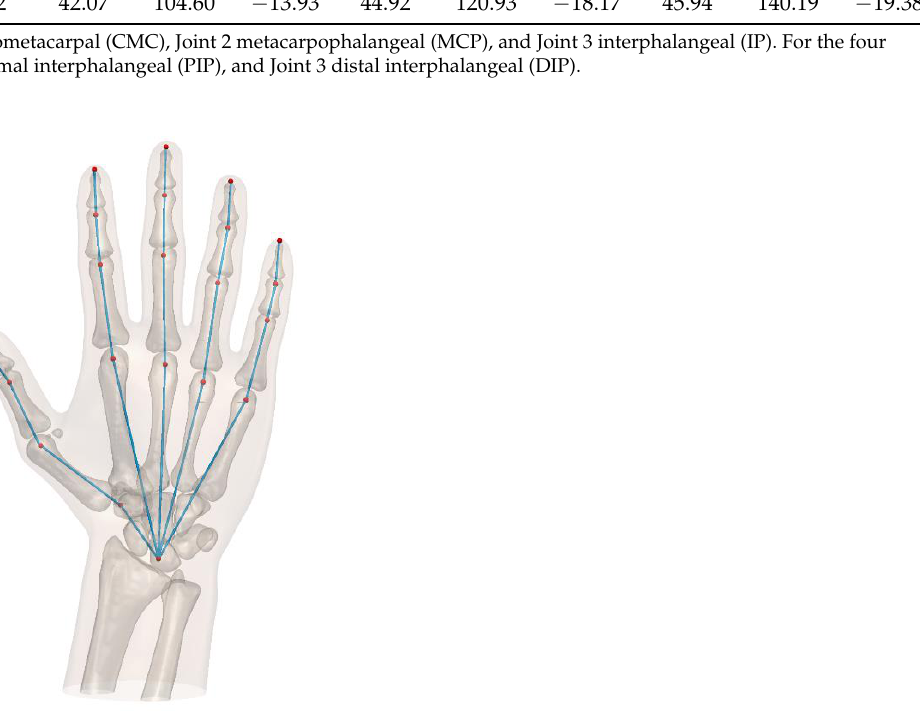
Figure 5. Linkage representation (blue) of a participant’s right hand by connecting the estimated joint centers (red). Table 2. Coefficients for estimating link length or segment length from hand length (A, where link length = A × hand